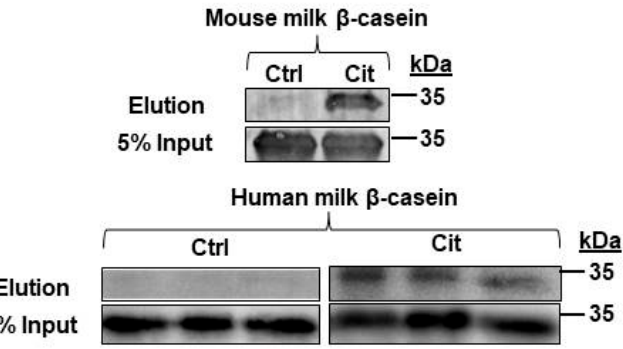
Figure 7. β -casein was citrullinated in mouse and human milk. L9 mouse milk and three human breast milk samples were labelled with biotin-PG (Cit) or without biotin-PG (Ctrl), enriched with streptavidin beads, and then separated by Western blot. PVDF membranes containing enriched citrullinated proteins were then probed with anti- β -casein antibodies. A 5% input sample was collected before enrichment and served as the loading control.